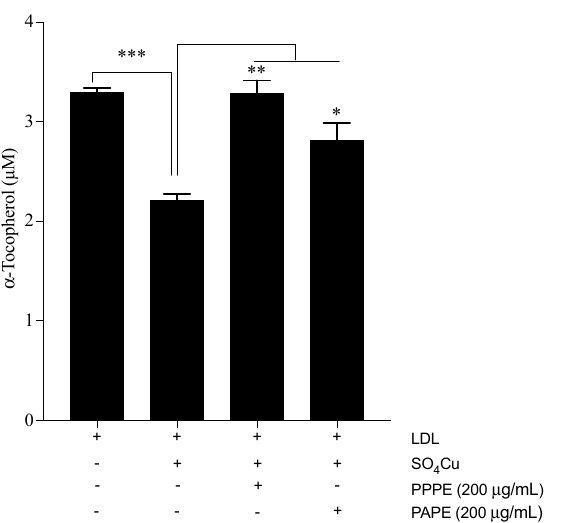
Figure 2. Effect of PPPE and PAPE on endogenous α -tocopherol disappearance during 4 h of CuSO 4 - induced low-density lipoprotein (LDL) oxidation. Results are expressed as the means ± sem of at least three independent assays. *** p < 0.001, ** p < 0.01 and * p < 0.05 indicate significant differences compared to the control.